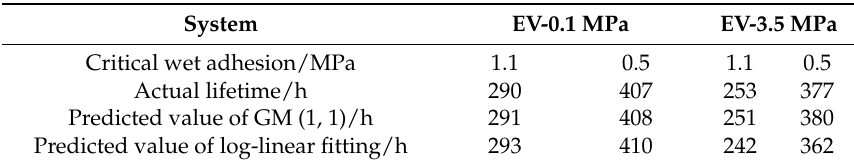
Table 6. The predicted values of two methods and the experimental data for EV coating/steel at different critical values of wet adhesion (1.1 MPa and 0.5